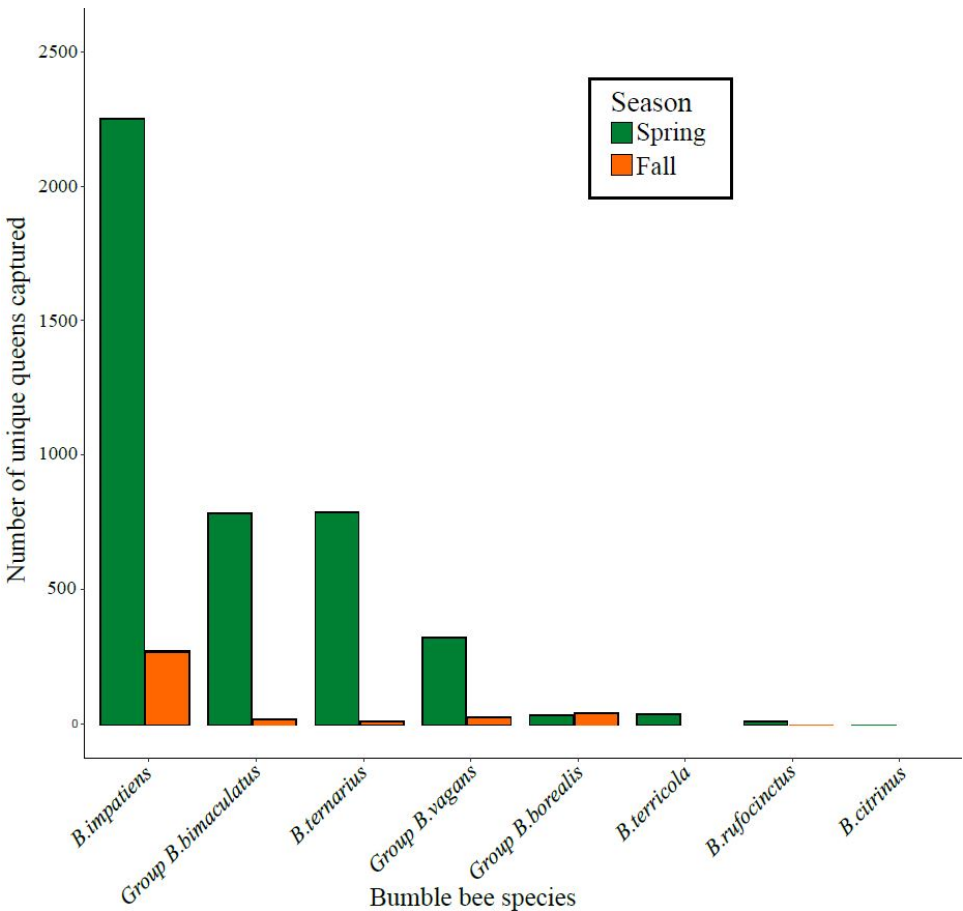
Figure 3. Total number of individual queens of the different species or morpho-species caught in apple orchards in fall or spring across the three years of the project (2017–2019).